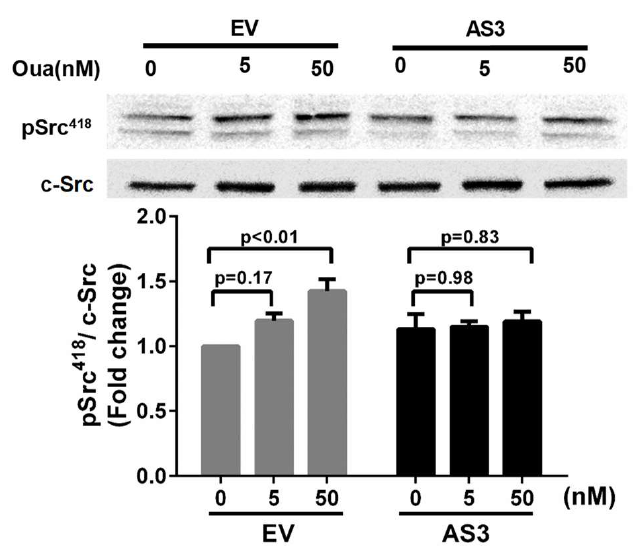
Figure 7. Overexpression of ATP1A1-AS1-203 inhibits ouabain-induced Src activation in HK2 cells. HK2 cells were transfected with ATP1A1-AS1-203 overexpressing vector (AS3) or empty vector (EV) for 24 h followed by ouabain (Oua) treatment for 15 min. Cell lysates were collected in RIPA buffer. The phospho-Src at Tyr418 (pSrc418) and c-Src were probed using Western blot. The upper panel was a representative Western blot, and the lower panel was the quantification result. These experiments were repeated four times. Data was analyzed using Two-way ANOVA.